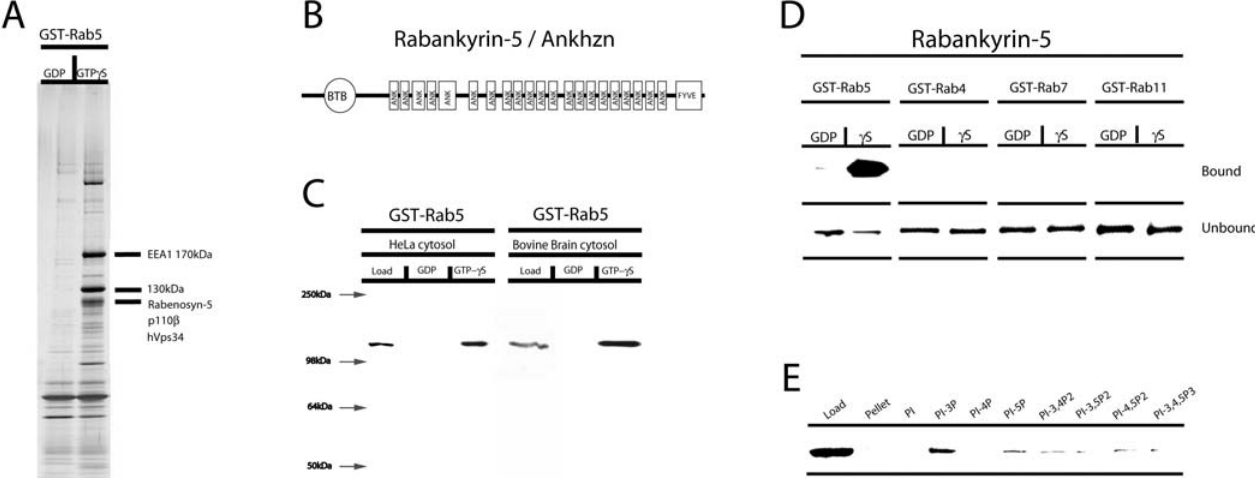
Figure 1. A Protein of 130 kDa Is a New Rab5 Effector (A) GST-Rab5-GDP and GST-Rab-GTP c S were loaded on beads and incubated with bovine brain cytosol. Bound proteins were eluted and analysed by SDS-PAGE followed by Coommasie Blue staining. The positions of the already known Rab5 effectors (EEA1, Rabaptin-5, hVps34, p110 b , and Rabenosyn-5) and of the new Rab5 effector are indicated. (B) Schematic representation of the domain organisation in Rabankyrin-5. ANK, ankyrin repeats. (C) Bovine brain cytosol or HeLa cell cytosol was incubated with GST-Rab5-GDP– or GST-Rab5-GTP c S–loaded beads. Subsequently the beads were washed, and bound proteins were eluted and analysed by Western blotting using anti–Rabankyrin-5 antibodies. (D) GST-Rab4, -5, -7, and -11 fusion proteins were preloaded with GDP or GTP c S and incubated with in vitro-translated 35 S-methionine–labelled Rabankyrin-5 full-length protein. As a control, bound and unbound material was analysed by SDS-PAGE followed by phosphoimager analysis. (E) Rabankyrin-5 binds most strongly to PI(3)P. Recombinant full-length Rabankyrin-5 was incubated with liposomes containing 2% of the indicated phosphoinositide. Bound Rabankyrin-5 was detected by Western